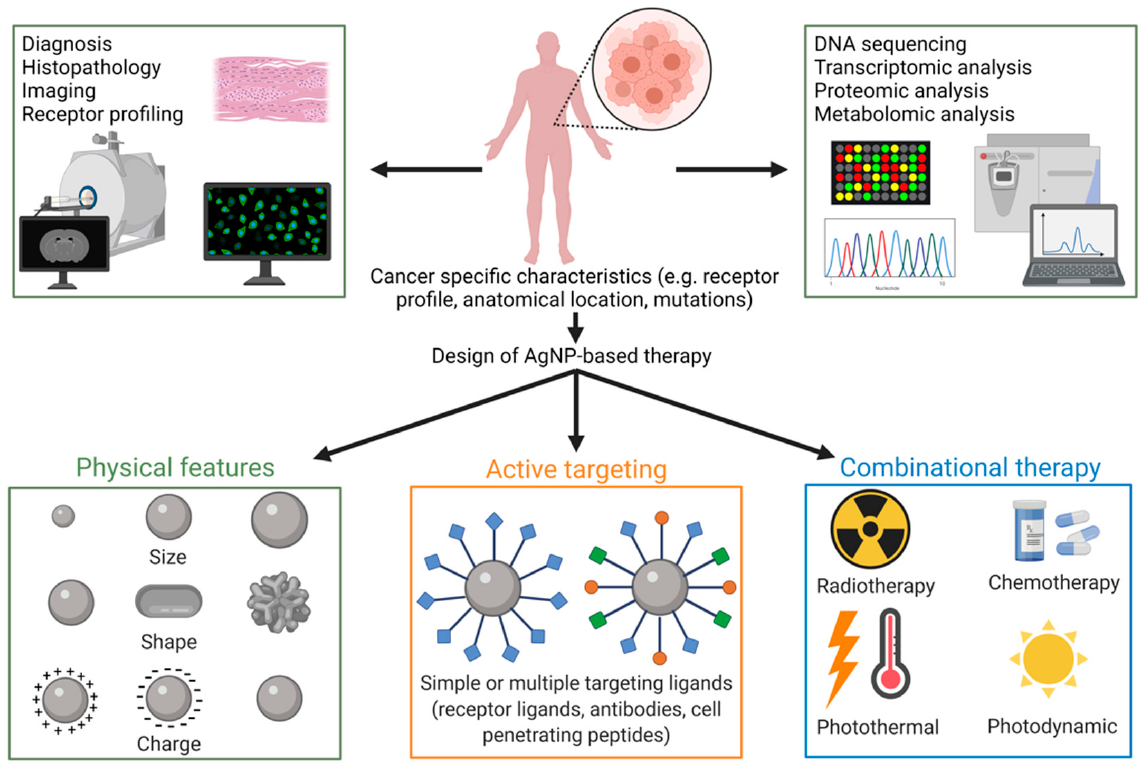
Figure 4. Merging modern diagnostic approaches provided by personalized cancer management and rational AgNP design can improve the anti-cancer efficiency of AgNPs. A detailed tumor phenotyping based on imaging and traditional histology techniques, together with high-throughput molecular characterization methods, can aid to select and design the ideal nanoparticle candidate with optimal size/shape, targeting the moiety and therapeutic combinational partner for each patient. The figure was created with Biorender.com.